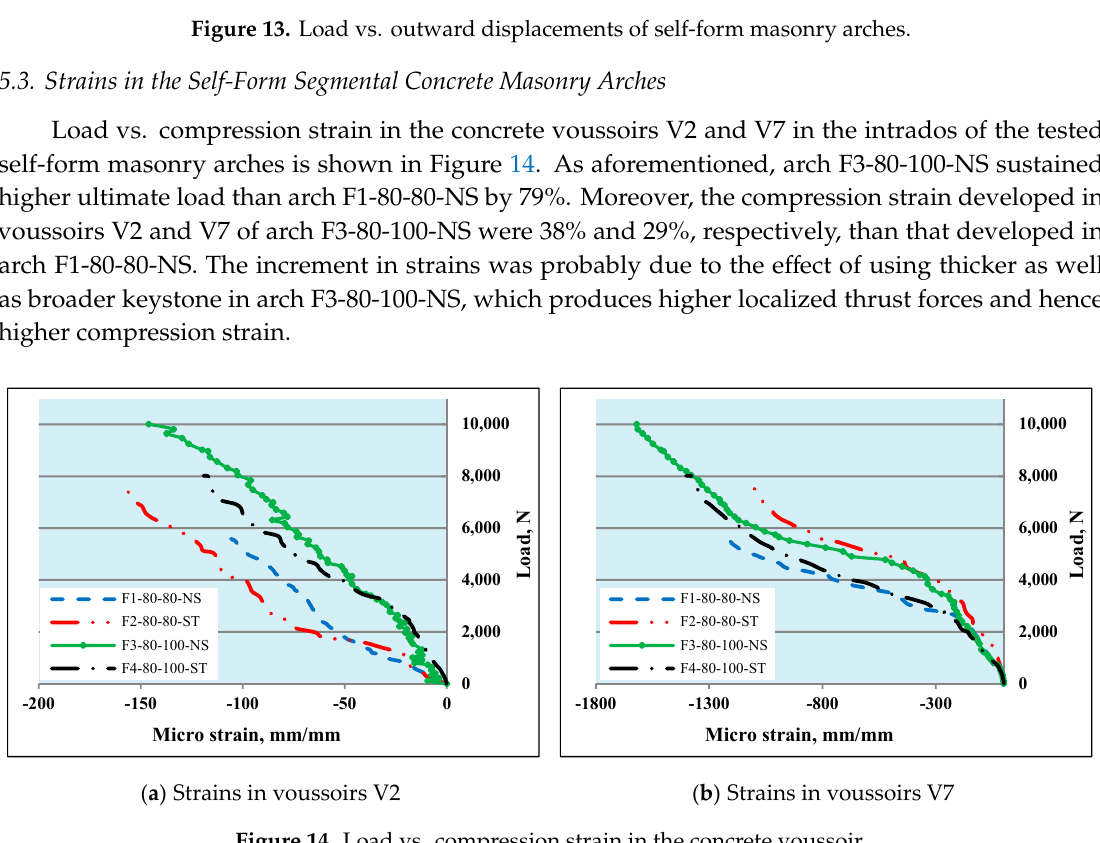
Figure 14. Load vs. compression strain in the concrete voussoir.